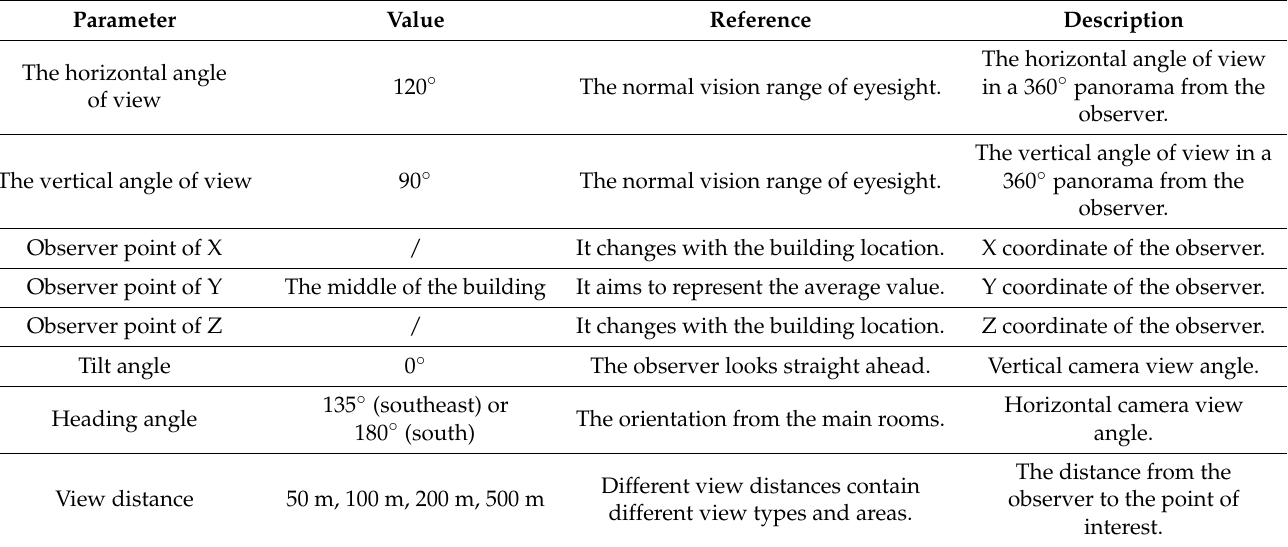
Table 4. Parameter setting for viewshed